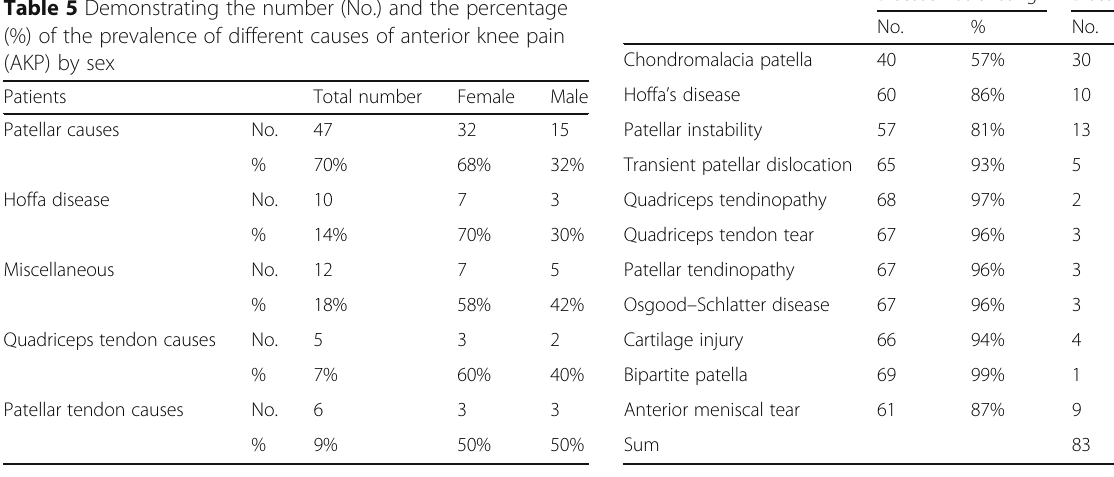
Table 6 Demonstrating the prevalence of 11 diseases entities found among the patients in the study sample. This table showed the largest percentage of the patients suffered from the chondromalacia patella Disease not existing Disease